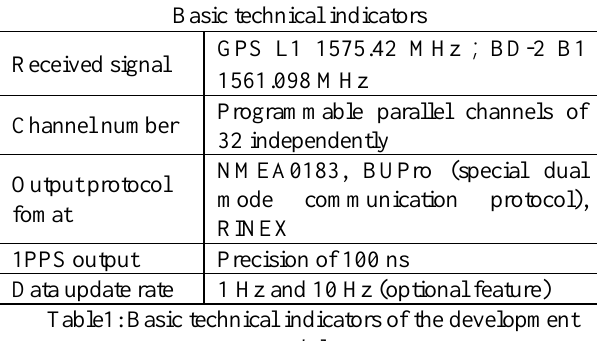
Table1: Basic technical indicators of the development module